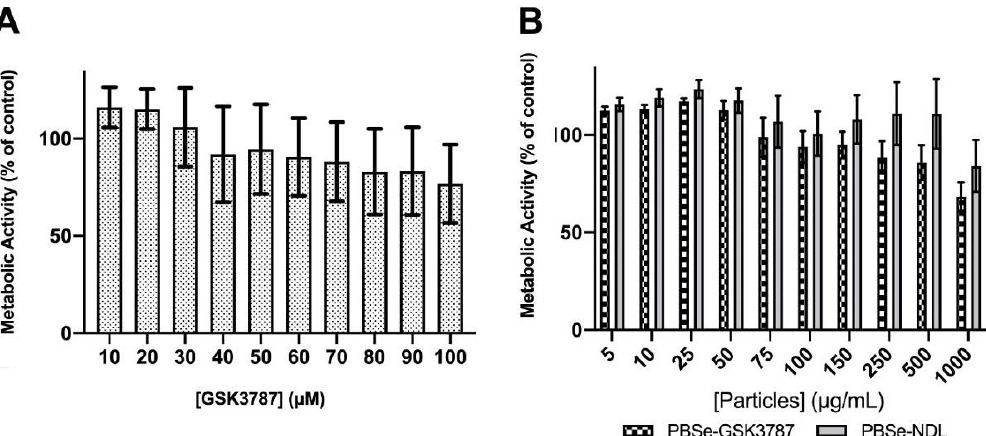
Figure 6. Metabolic activity of immature murine articular cartilage (IMAC) cells, as measured by the 3-(4,5-dimethylthiazol-2-yl)-2,5-diphenyl tetrazolium bromide (MTT) assay 48 h after treatment with ( A ) increasing concentrations of the PPAR δ inhibitor, GSK 3787 and ( B ) PBSe-GSK3787 and PBSe-NDL particles. No significant toxicity was observed for the free drug or for PBSe-NDL. However, a trend towards higher toxicity was observed for PBSe-GSK3787 particles. Error bars correspond to standard deviations (N = 4).